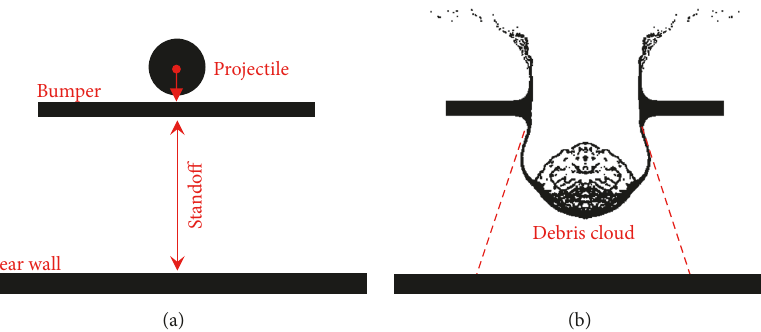
Figure 1: Schematic of an orbital debris shield before impact (a) and after perforation of the bumper (b).